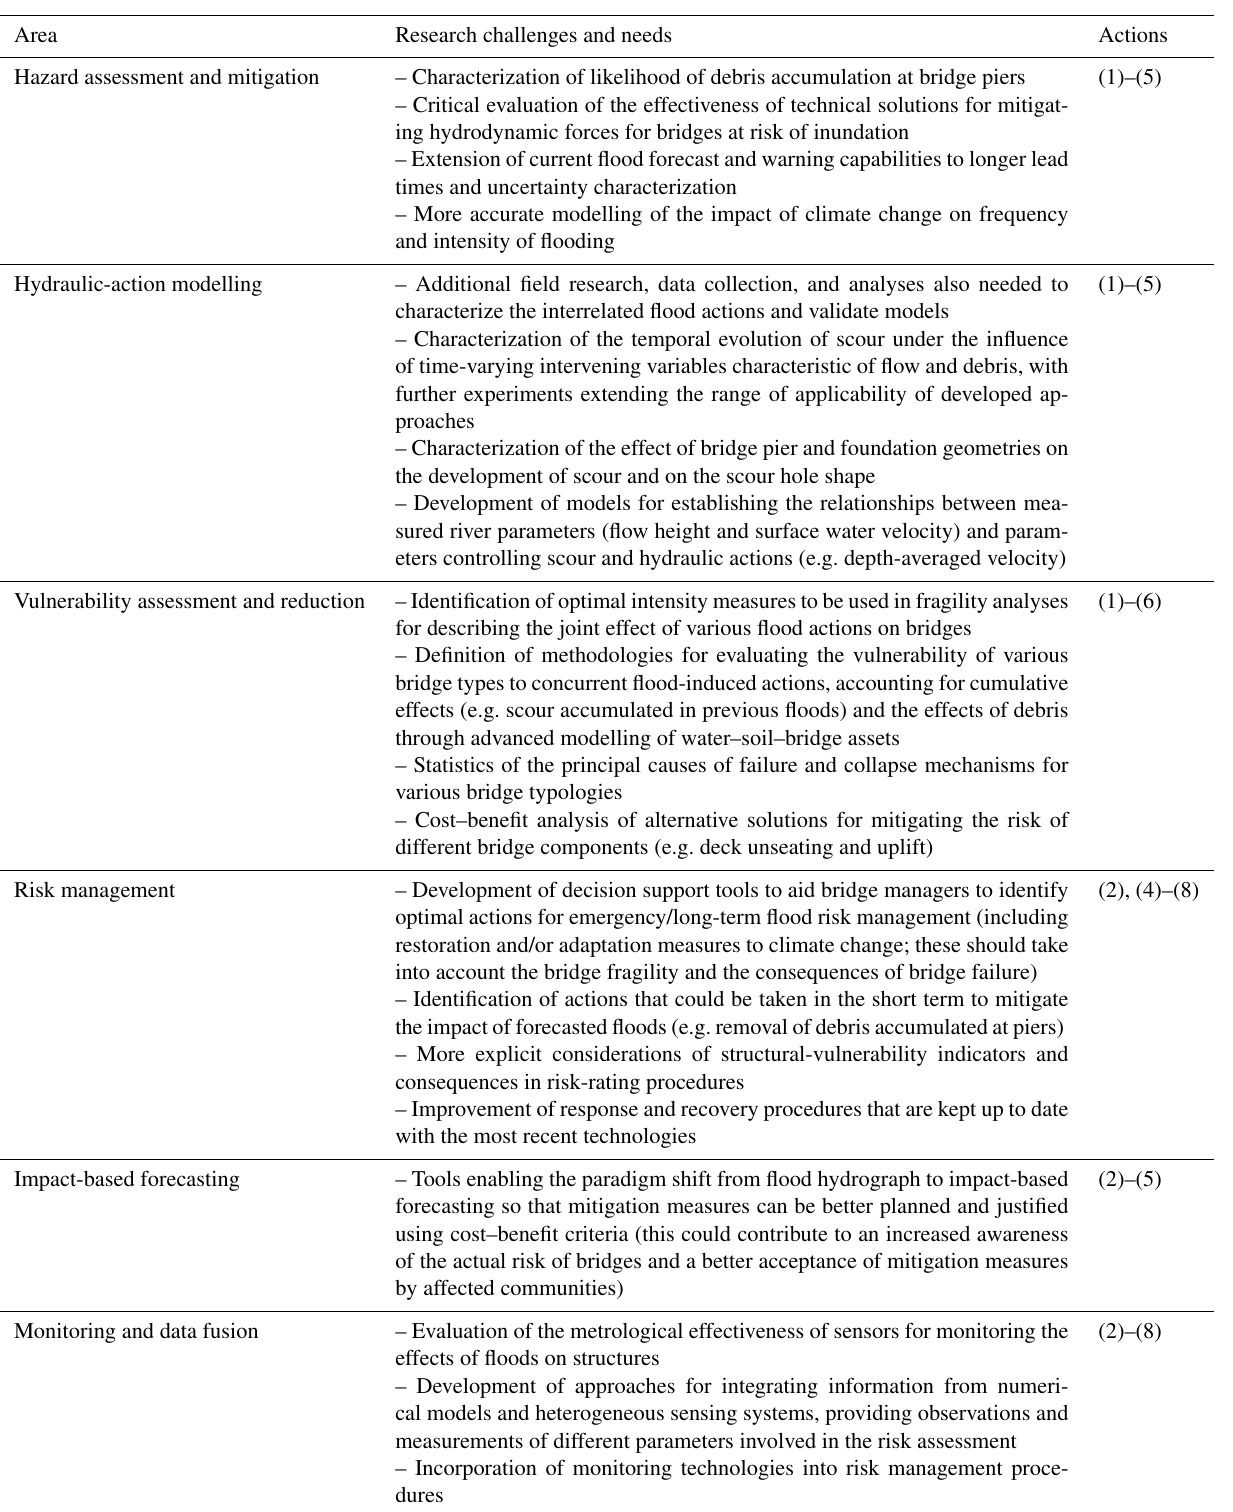
Table 1. List of research areas, challenges and needs, and actions for improving bridge resilience to flooding.